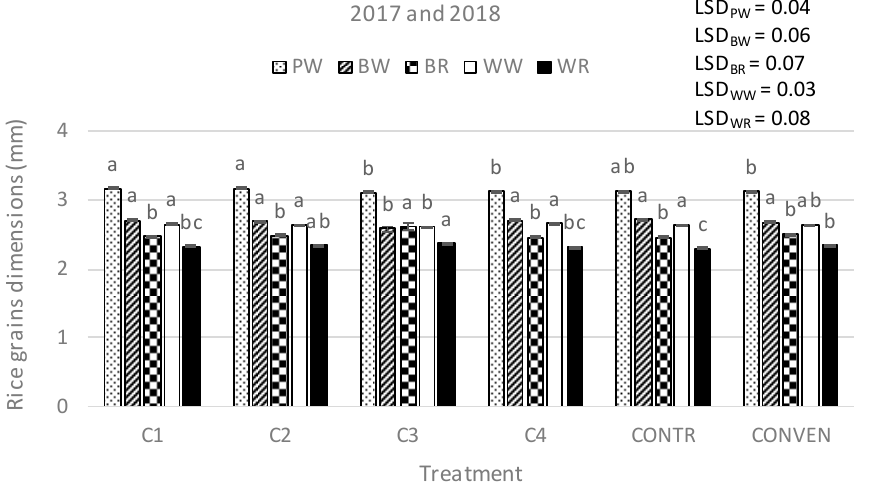
Figure 11. Width of paddy (PW), width (BW) and length / width ratio (BR) of brown, and width (WW) and length / width ratio (WR) of white rice grains (means ± se), harvested of rice plants grown in di ff erently fertilized soil of the experiments during 2017 and 2018. Treatments contain